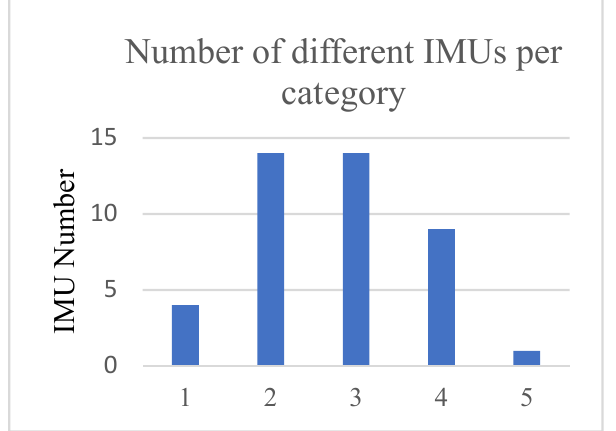
Figure 7. Number of IMUs depending on the number of sensors they include.